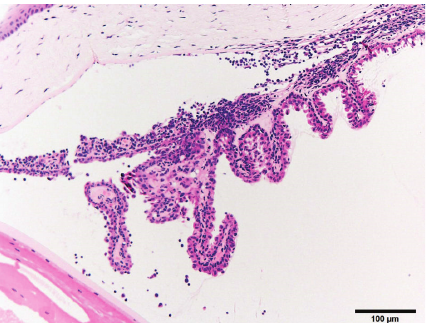
Figure 2: Photomicrograph of the ciliary body/iris of the eye from a 50-week-old female SDT fatty rat. There is infiltration of inflammatory cells in the ciliary body, iris, the anterior and posterior chambers, and the angle of anterior chamber. Bar = 100 𝜇 m. Hematoxylin and eosin.